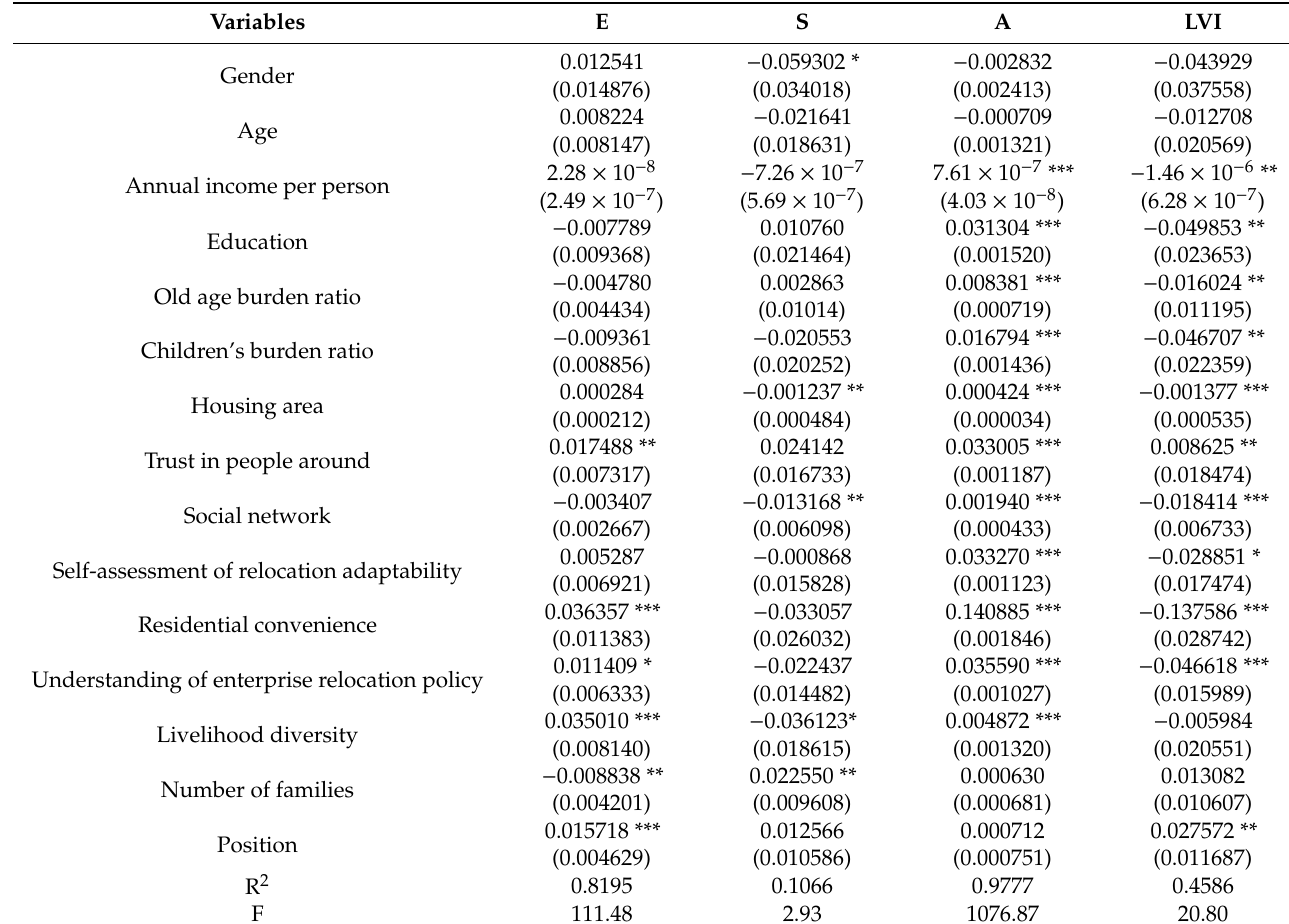
Table 5. Estimated results of influencing factors on livelihood vulnerability of employees in relocated